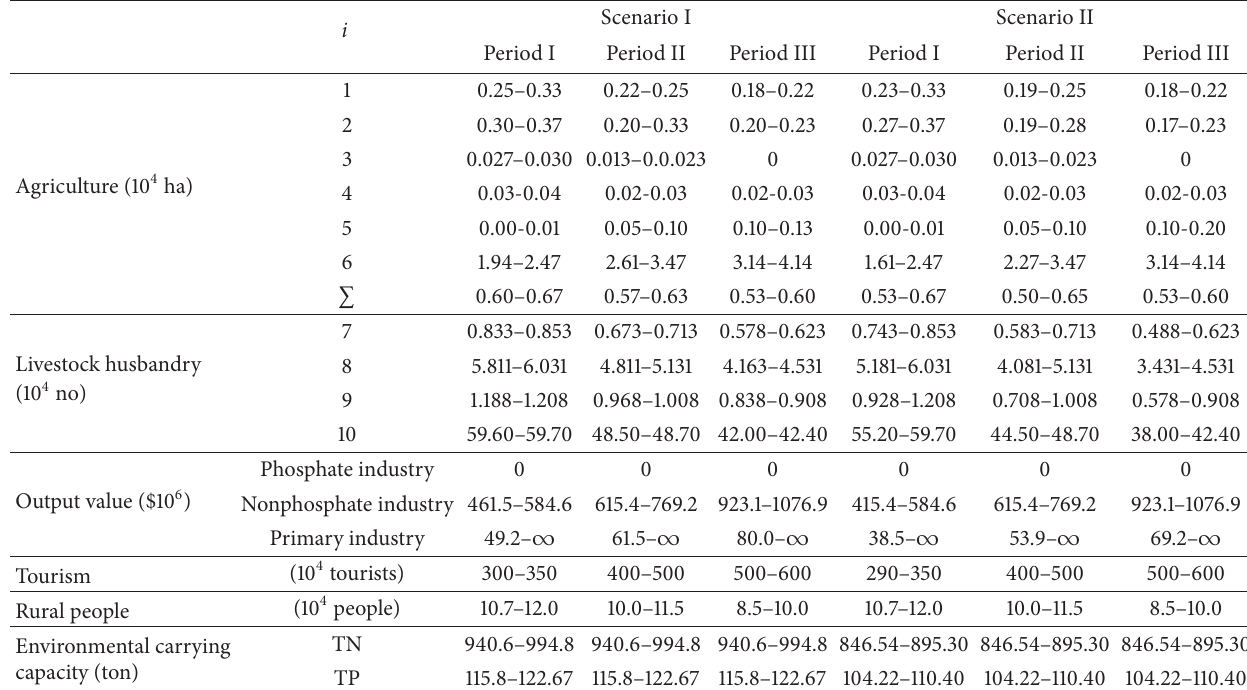
Table 2: Constraints in three periods under two